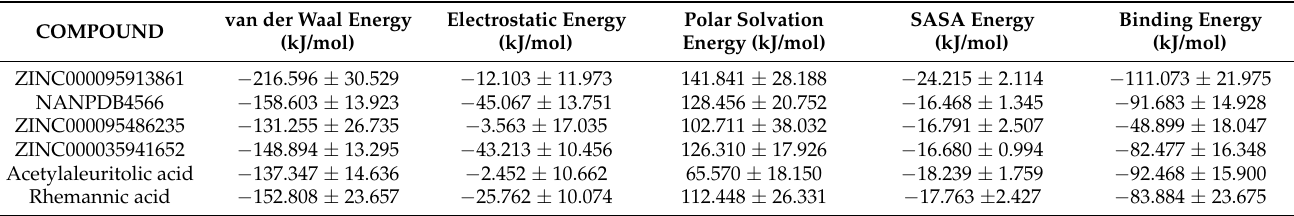
Table 4. Binding free energies and the other contributing energies of the WSP-ligand complexes from MMPBSA computation. Energy values are presented as average ± standard deviations in kJ/mol.